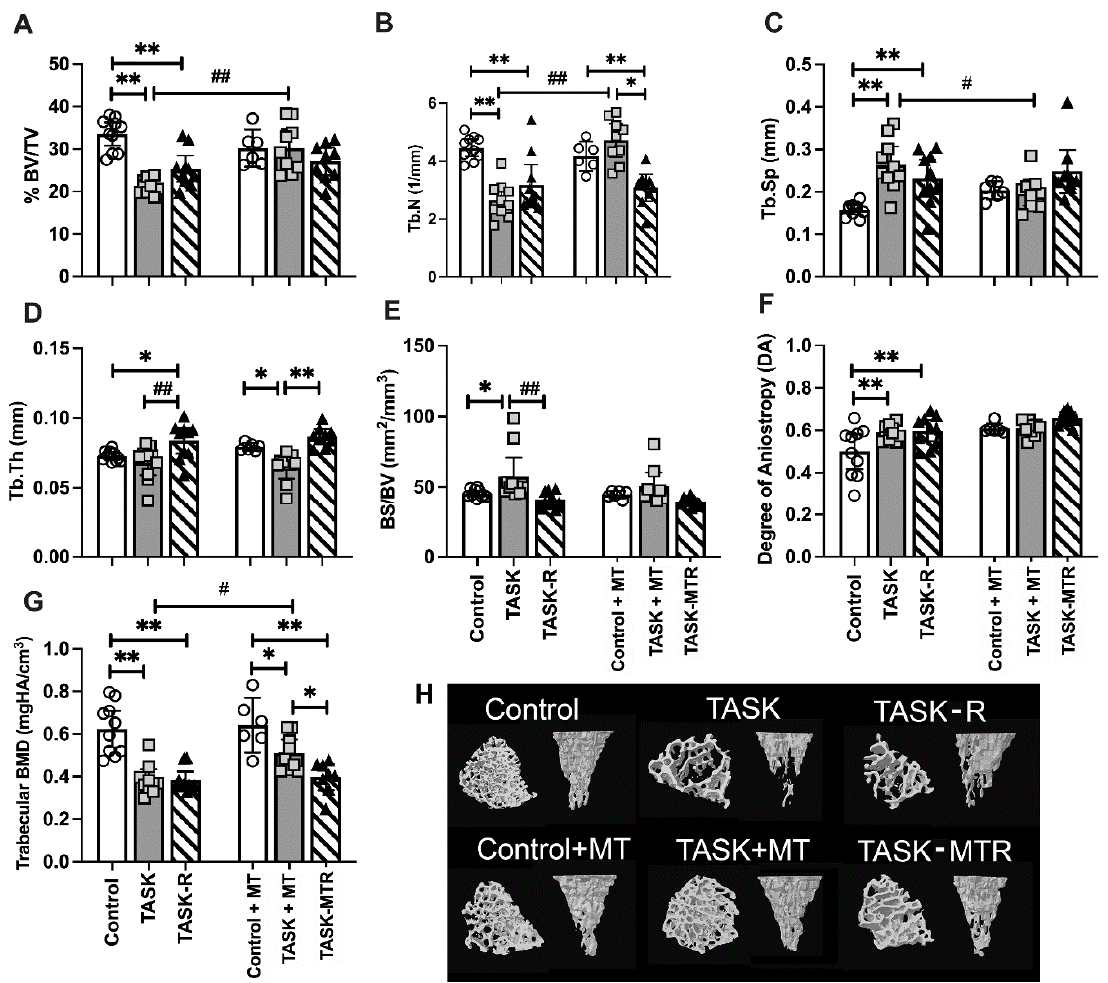
Figure 2. Micro-computerized tomography (MicroCT) of distal radial metaphyseal trabecular bone. ( A – G ) Percent bone volume normalized to total volume (% BV/TV), trabecular number (Tb.N), trabecular separation (Tb.Sp), trabecular thickness (Tb.Th), bone surface density (bone surface normalized to bone volume; BS/BV), degree of anisotropy (DA), trabecular bone mineral density (BMD). Mean ± 95% confidence intervals (CIs) shown. ( H ) Representative transaxial and coronal images of the middle region of the trabecular zone of the distal radial metaphysis for each group. The transaxial view is shown from the top near the growth plate. Abbreviations: control rats (Control); 12- week TASK rats (TASK); TASK rats that rested for 6 weeks after task cessation (TASK-R); control rats that received manual therapy for 12 weeks (Control+MT); TASK rats that simultaneously re- ceived manual therapy for 12 weeks (TASK+MT); TASK rats that rested for 6 weeks after task ces- sation while receiving manual therapy treatment of their upper limbs three times per week (TASK- MTR). # and ##: p < 0.05 and p < 0.01, respectively, compared to TASK group. * and **: p < 0.05 and p < 0.01, respectively, compared between groups as shown.